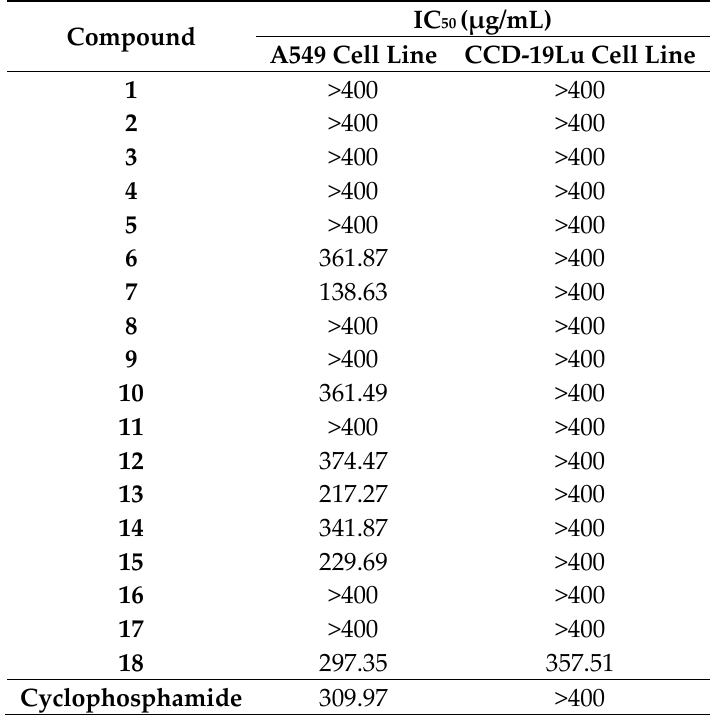
Table 1. IC 50 values of compounds 1–18 and